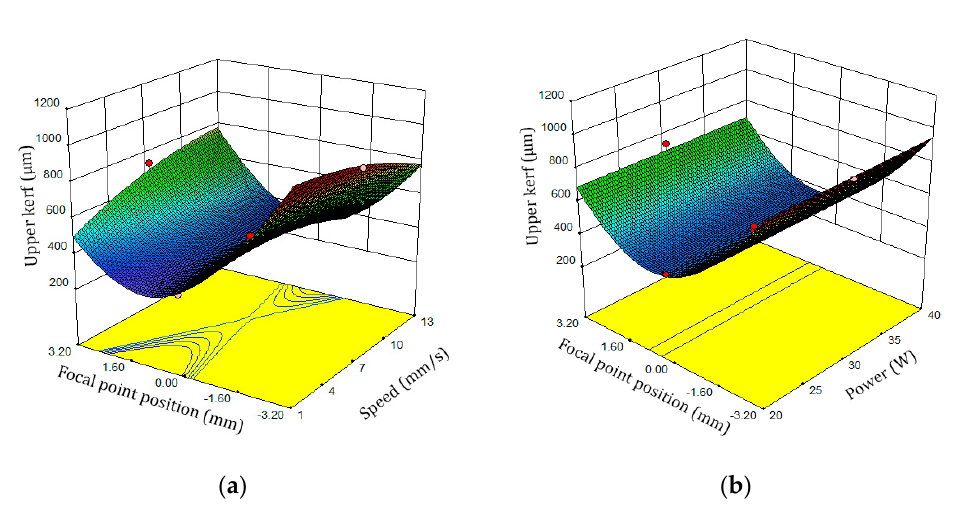
Figure 8. Response surface plots of the top kerf width. ( a ) FPP and cutting speed, ( b ) FPP and laser power